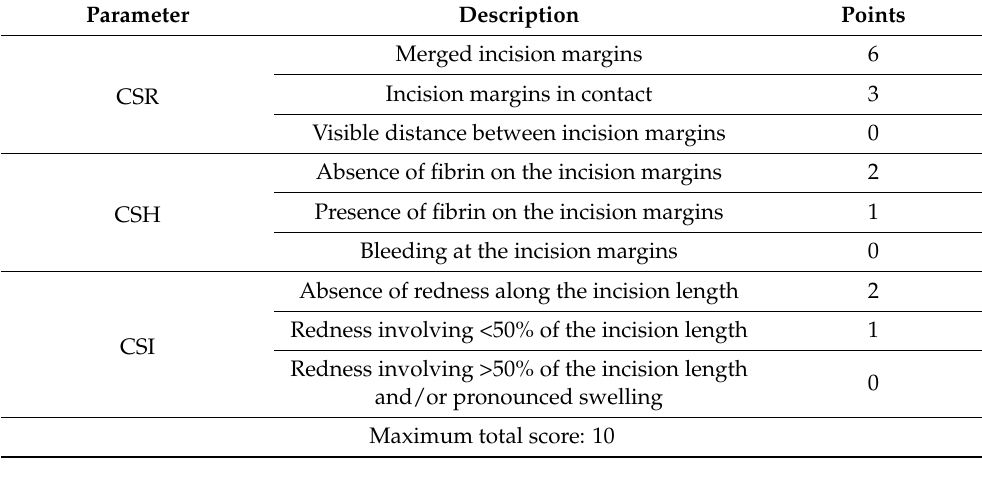
Table 1. EHS: Early Wound Healing Score, CSR: clinical signs of re-epithelialization, CSH: clinical signs of hemostasis, CSI: clinical signs of inflammation.